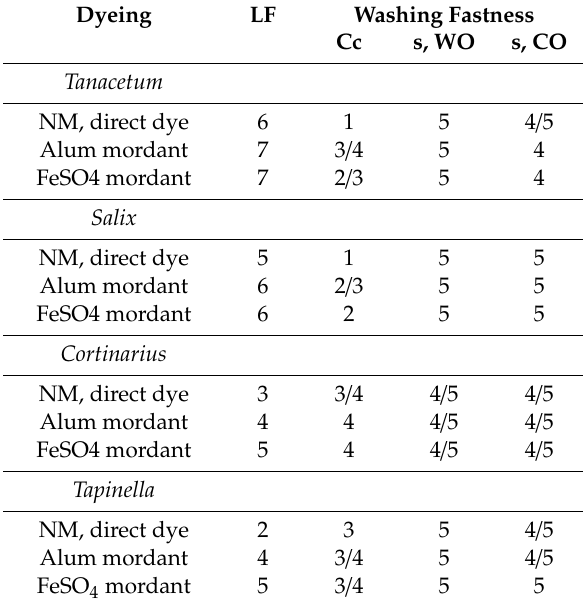
Table 4. Colour fastnesses to light (scale 1 − 8) and washing (scale 1 − 5). LF = light fastness (200 h without side change), Cc = colour change, s = staining, NM = no mordant. Dyeing LF Washing Fastness Cc s, WO s, CO Tanacetum NM, direct dye 6 4 / 5 Alum